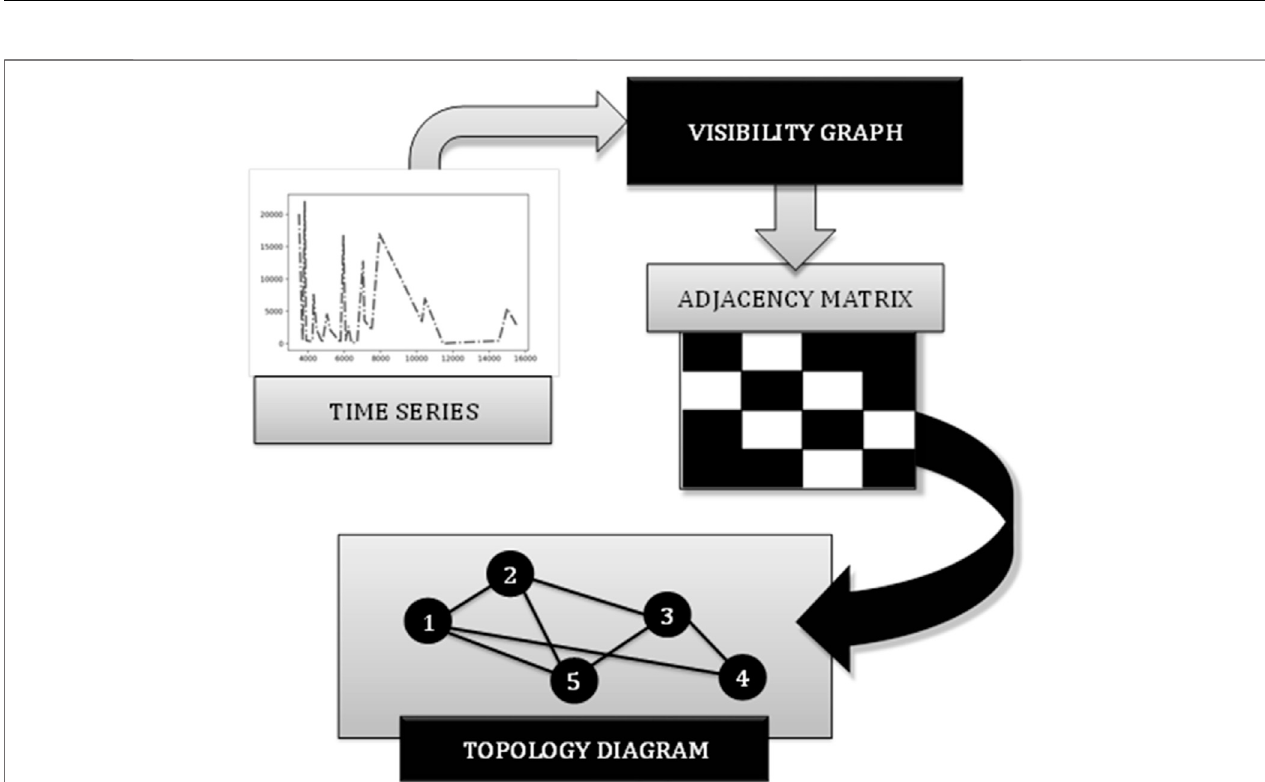
FIGURE 3 | Construction of the time-series network and extraction of